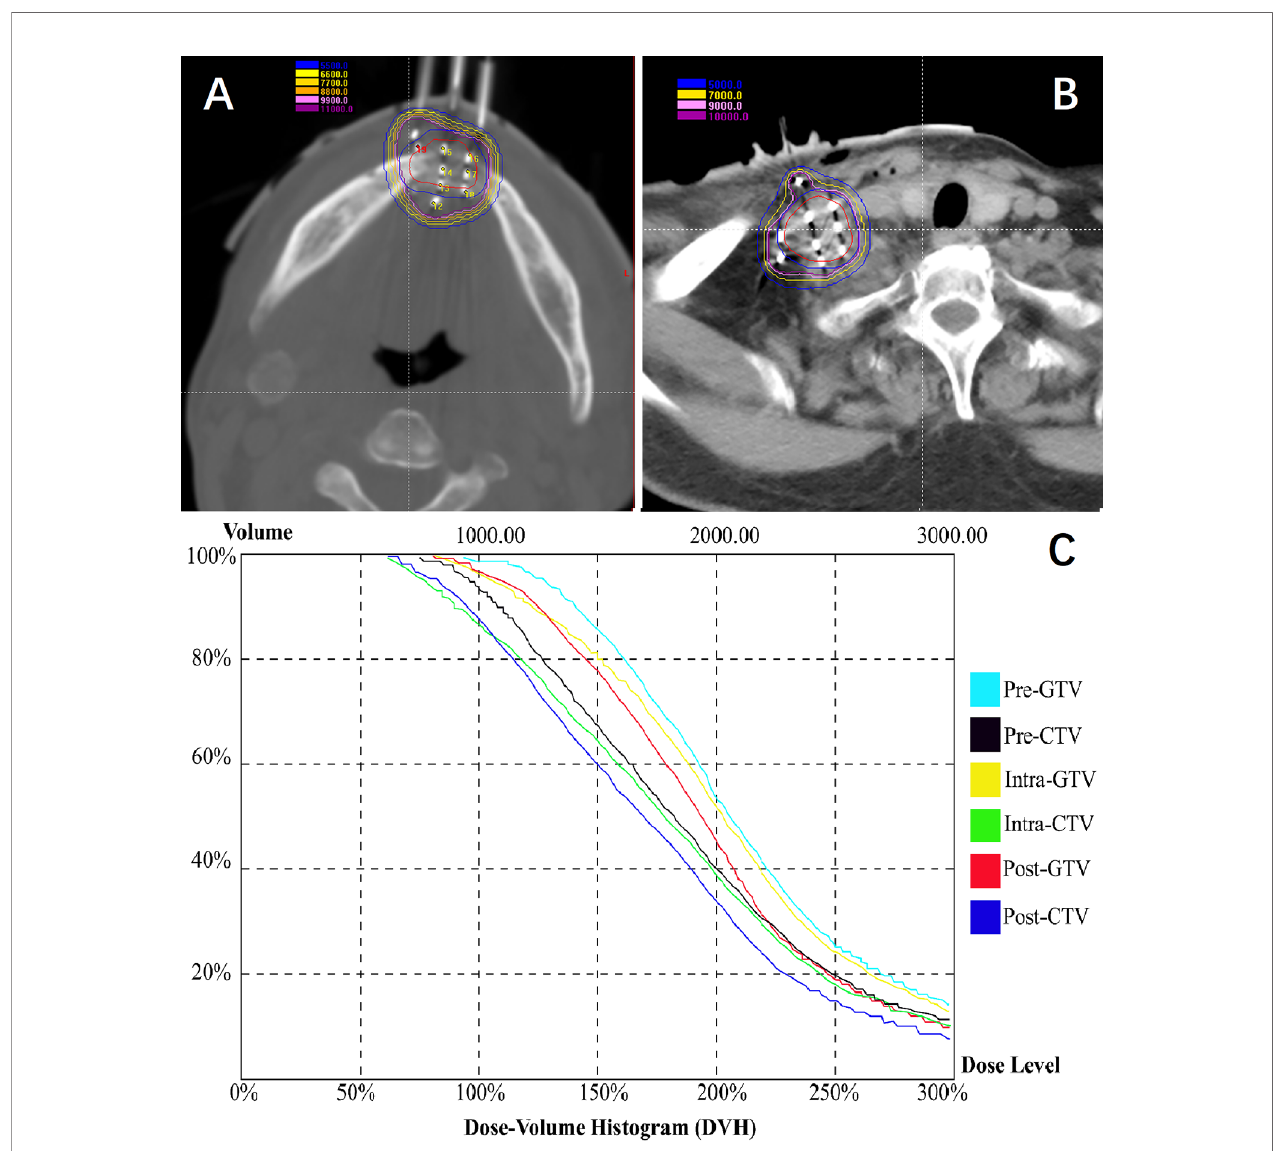
FIGURE 5 | Patients were re-evaluated immediately with a CT scan after I 125 radioactive seed implantation. (A, B) Validation of postoperative distribution of the I 125 seeds; (C) The dose-volume histogram of preoperative planning, intraoperative re-plan, and postoperative